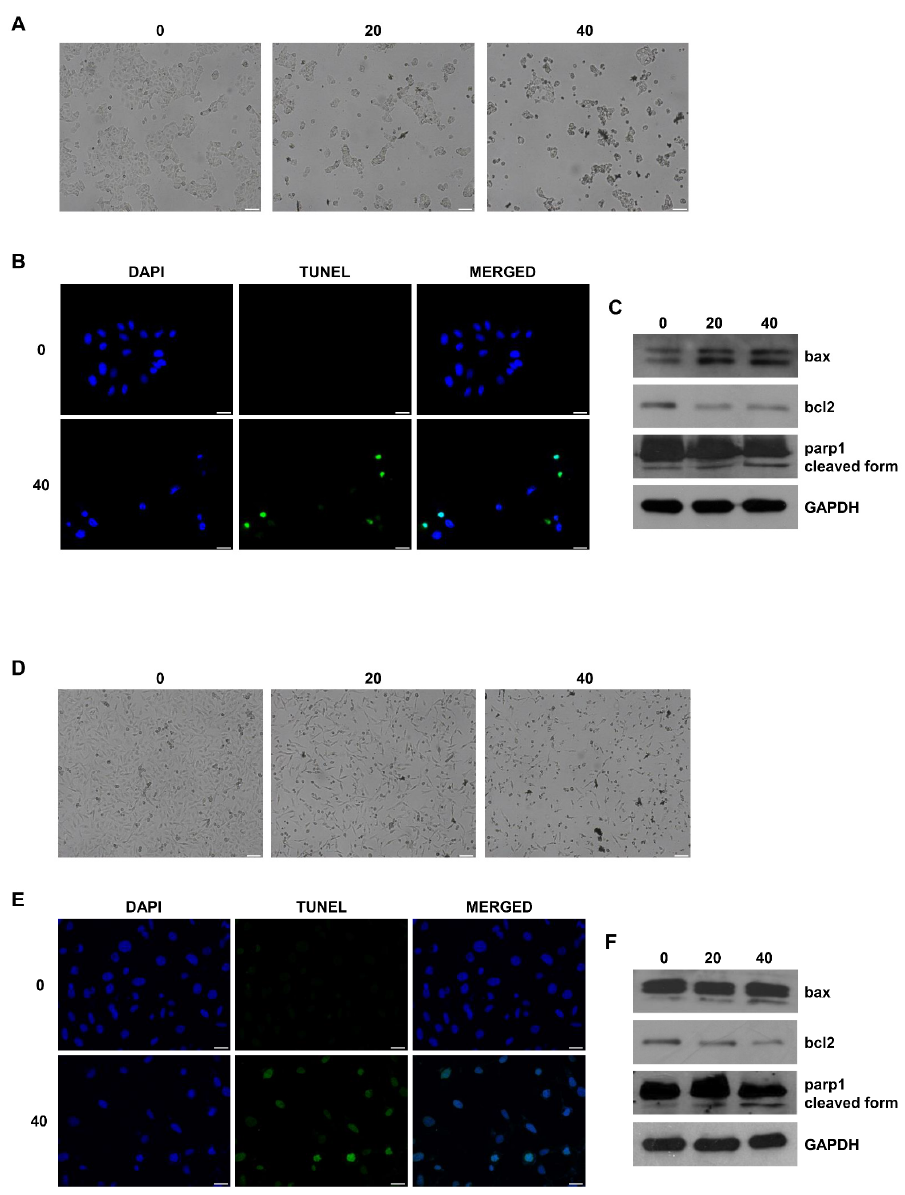
Figure 5. Effects of derivative 2 on MCF7 and MDA-MB231 cell morphology and apoptosis. MCF7 ( A ) and MDA-MB231 ( D ) cells were untreated (0) or treated with derivative 2 (20 and 40 µ M) for 24 h; after treatment, cells were examined with a phase-contrast microscope ( × 10 objective). Images are from a representative experiment. Scale bar: 100 µ m. ( B , E ) MCF7 ( B ) and MDA-MB231 ( E ) cells were untreated (0) or treated with derivative 2 (10 µ M) for 72 h; after treatment, cells were fixed with paraformaldehyde and processed for TUNEL staining. Nuclei counterstaining was performed using DAPI. Fluorescent signals were observed under a fluorescent microscope ( × 20 objective). Images are from a representative experiment. Scale bar: 50 µ m. ( C , F ) MCF7 ( C ) and MDA-MB231 ( F ) cells were untreated (0) or treated with derivative 2 (20 and 40 µ M) for 24 h. Western blot analyses of bax, bcl-2, and parp1 were performed on equal amounts of total proteins. Blots are representative of three independent experiments with similar results. GAPDH was used as a loading